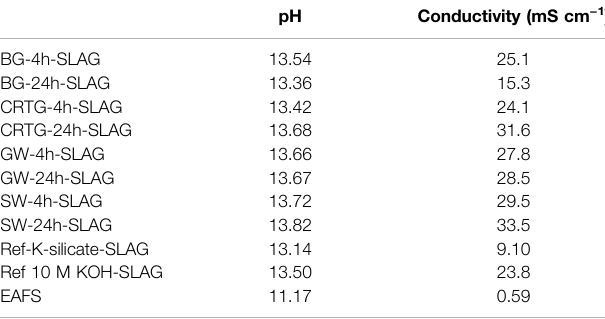
TABLE7| ThepHandionicconductivityvaluesoftheAAMsamplespreparedand the slag before alkali activation.